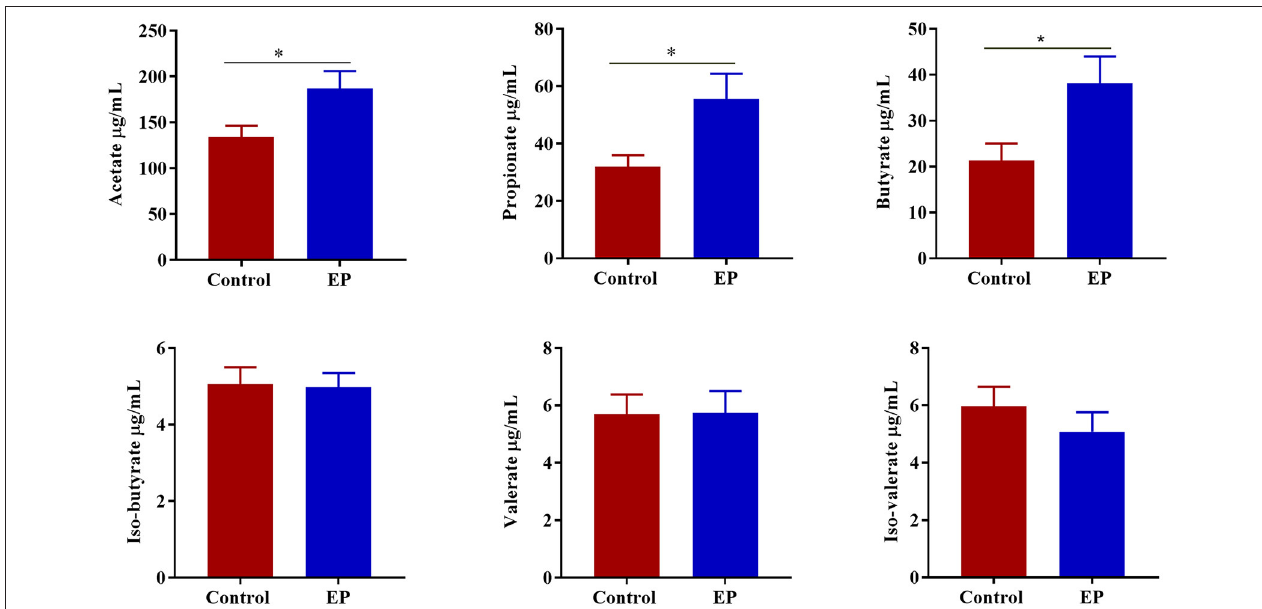
FIGURE 7 | The effects of EP supplementation on the short chain volatile fatty acid concentration from caecal content of broiler chickens. * P < 0.05.